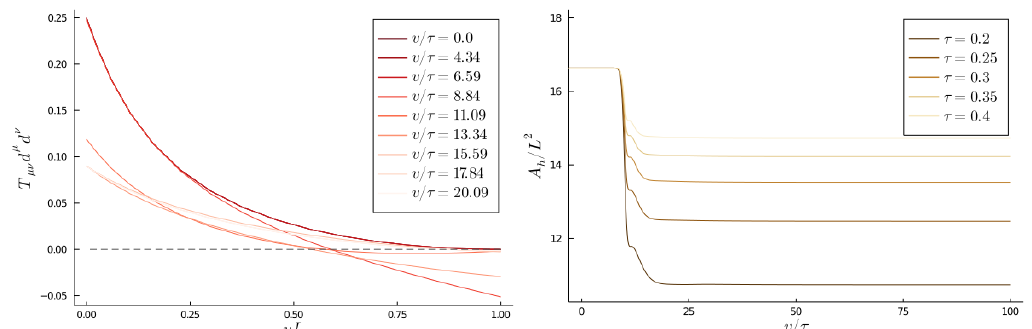
Figure 3: (Top) We check the NEC T µν d µ d ν ≥ 0 for the particular simulation of figure 1 with τ = 0.4 at different stages v /τ of the evolution. It is clearly violated, especially at the horizon uL = 1. (Bottom) We display the size of the apparent horizon for the simulations of figure 1. All of them show a shrinking horizon, which is tightly related to violating the